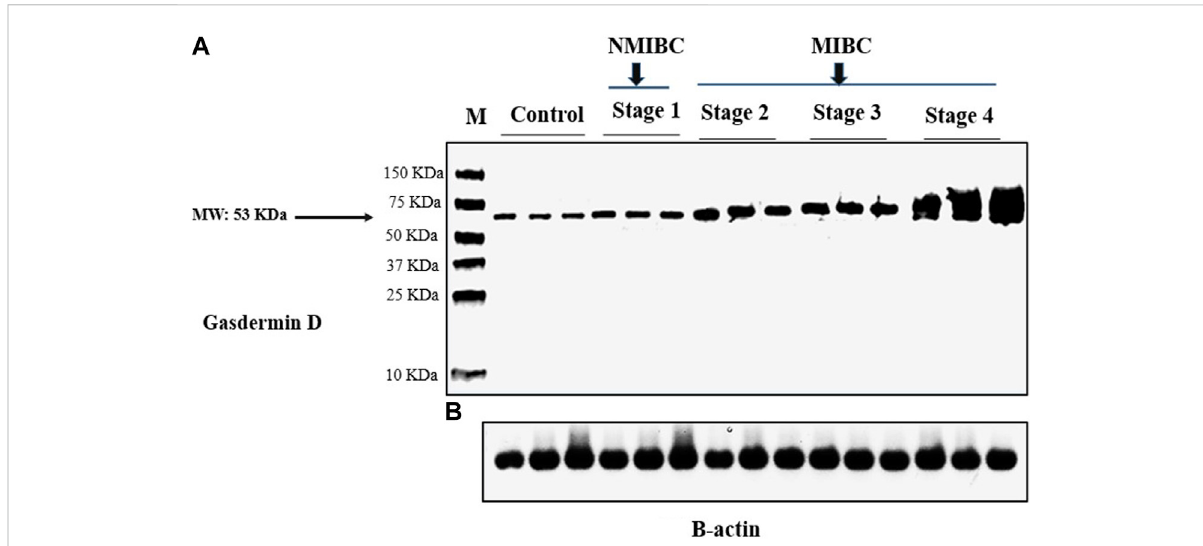
FIGURE 1 Gasdermin D protein analysis in tissue samples by western blotting in the study groups: (A) Gasdermin D protein bands (Molecular weight: 53 kDa). (B) β -actin protein bands (Molecular weight: 42 kDa). β -actin was utilized to be an internal control. NMIBC: Non-muscle invasive bladder cancer. MIBC: Muscle invasive bladder cancer. M: Molecular weight